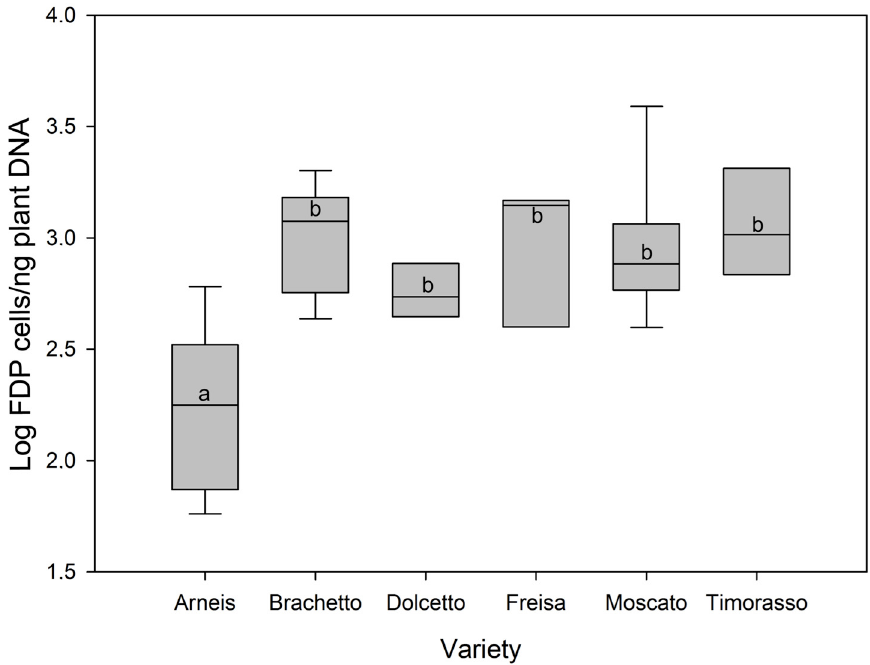
Figure 1. Mean Flavescence dorée phytoplasma loads in grapevines of different cultivars. Different letters refer to different mean values separated through the Holm–Sidak multiple comparison test.